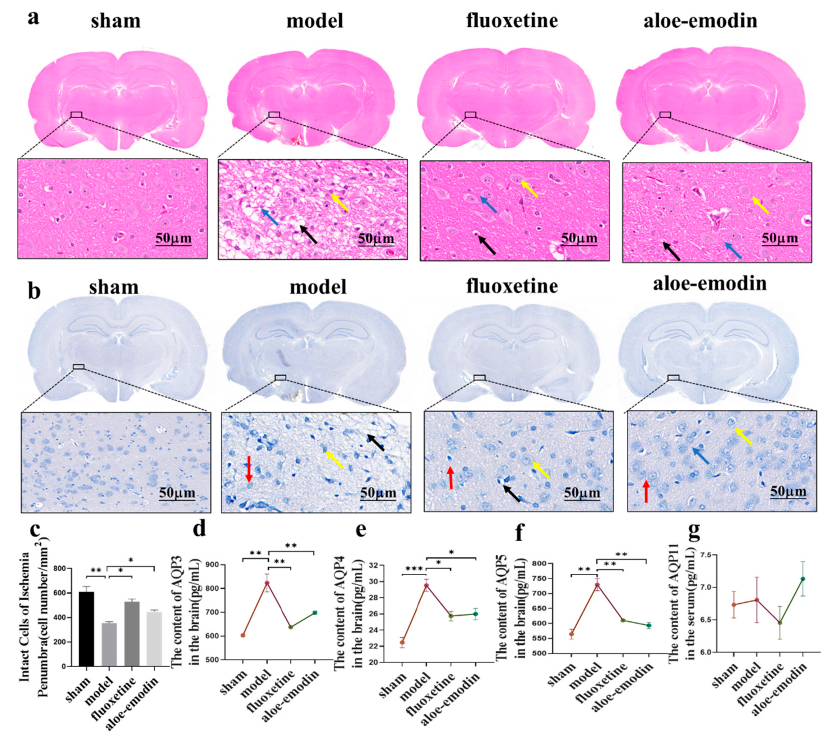
Figure 2. ( a ) Brain tissue slice stained with H&E staining; ( b ) brain tissue slice stained with Nissl staining; ( c ) quantitative analysis of Nissl bodies (n = 3); ( d ) ELISA detection of AQP3 expression in the rats’ brain tissue (n = 3); ( e ) ELISA detection of AQP4 expression in the rats’ brain tissue (n = 3); ( f ) ELISA detection of AQP5 expression in the rats’ brain tissue (n = 3); and ( g ) ELISA detection of AQP3 expression in the rats’ brain tissue (n = 3). * p < 0.05, ** p < 0.01, and *** p < 0.001.